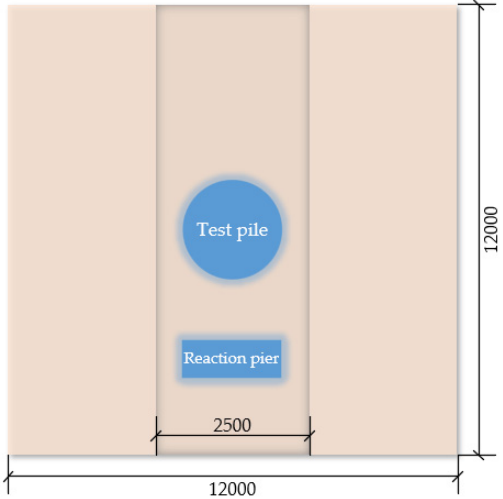
Figure 3. Schematic diagram of static load test site of the test pile. (Unit: mm).